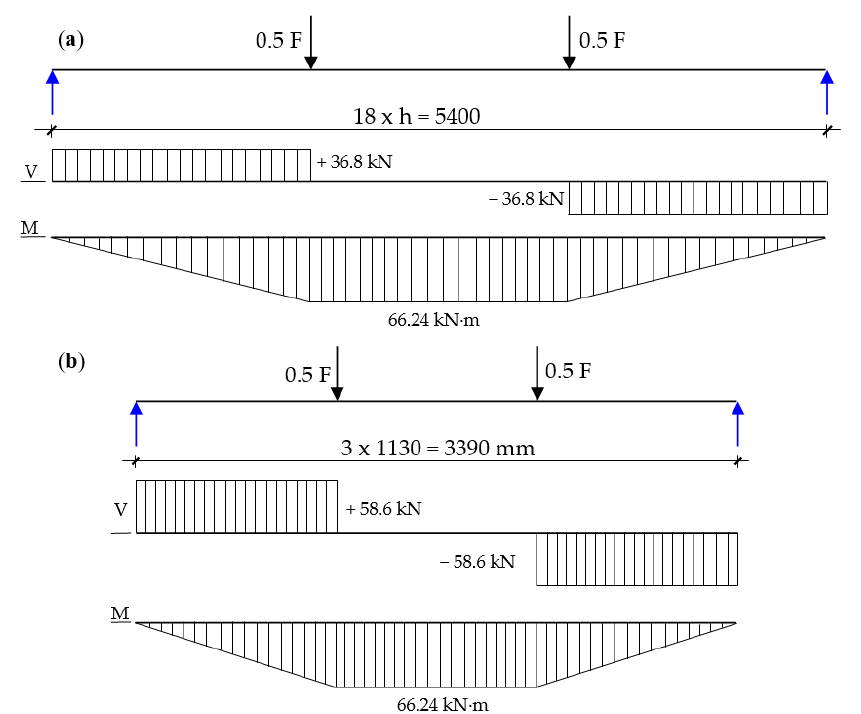
Figure 9. ANOVA of the assessment of the static bending strength and modulus of elasticity relative to the point of destruction (Letters mark uniform groups determined with the Tukey HSD test).